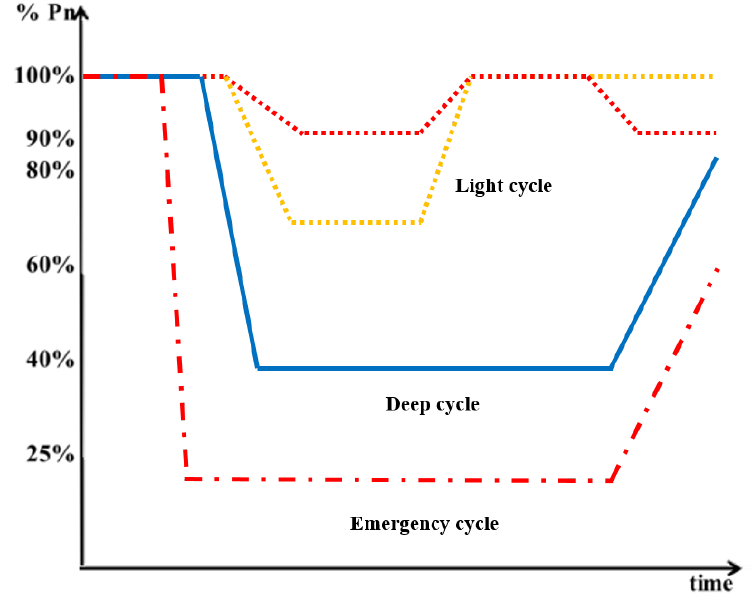
Figure 3. Load-following capability by cycle type.